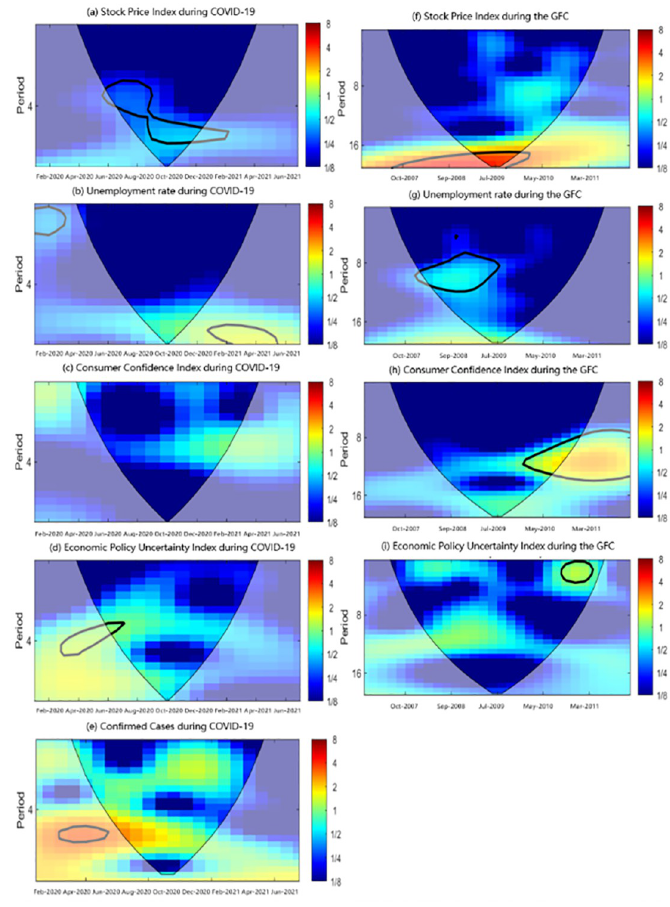
Fig 2. CWT plots for the SPI, EPU, CCI and unemployment rate during COVID-19 and GFC in